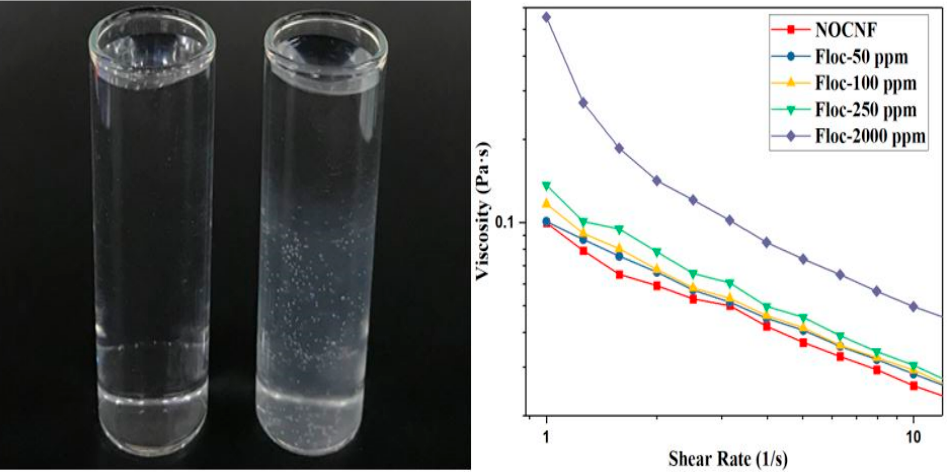
Figure 2. Photograph showing the NOCNF suspension (0.2 wt%) and the floc form by mixing NOCNF (0.2 wt%) with 100 ppm Tl(I). The viscosity of the floc sample increases with the increasing Tl(I) concentration.